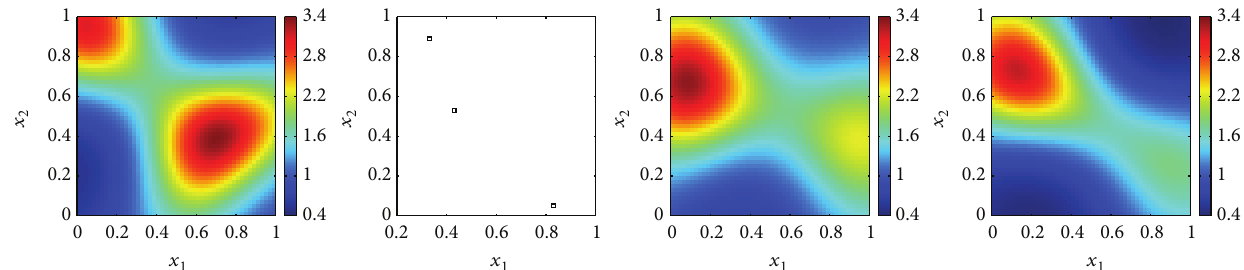
Figure 11: Example from Section 4.3. Far left: permeability field used as a source of data for conditional simulations with KL-SC. Left: location of 𝑁 𝑚 = 3 data points x ∗ . Right and far right: two realizations of conditional permeability field for